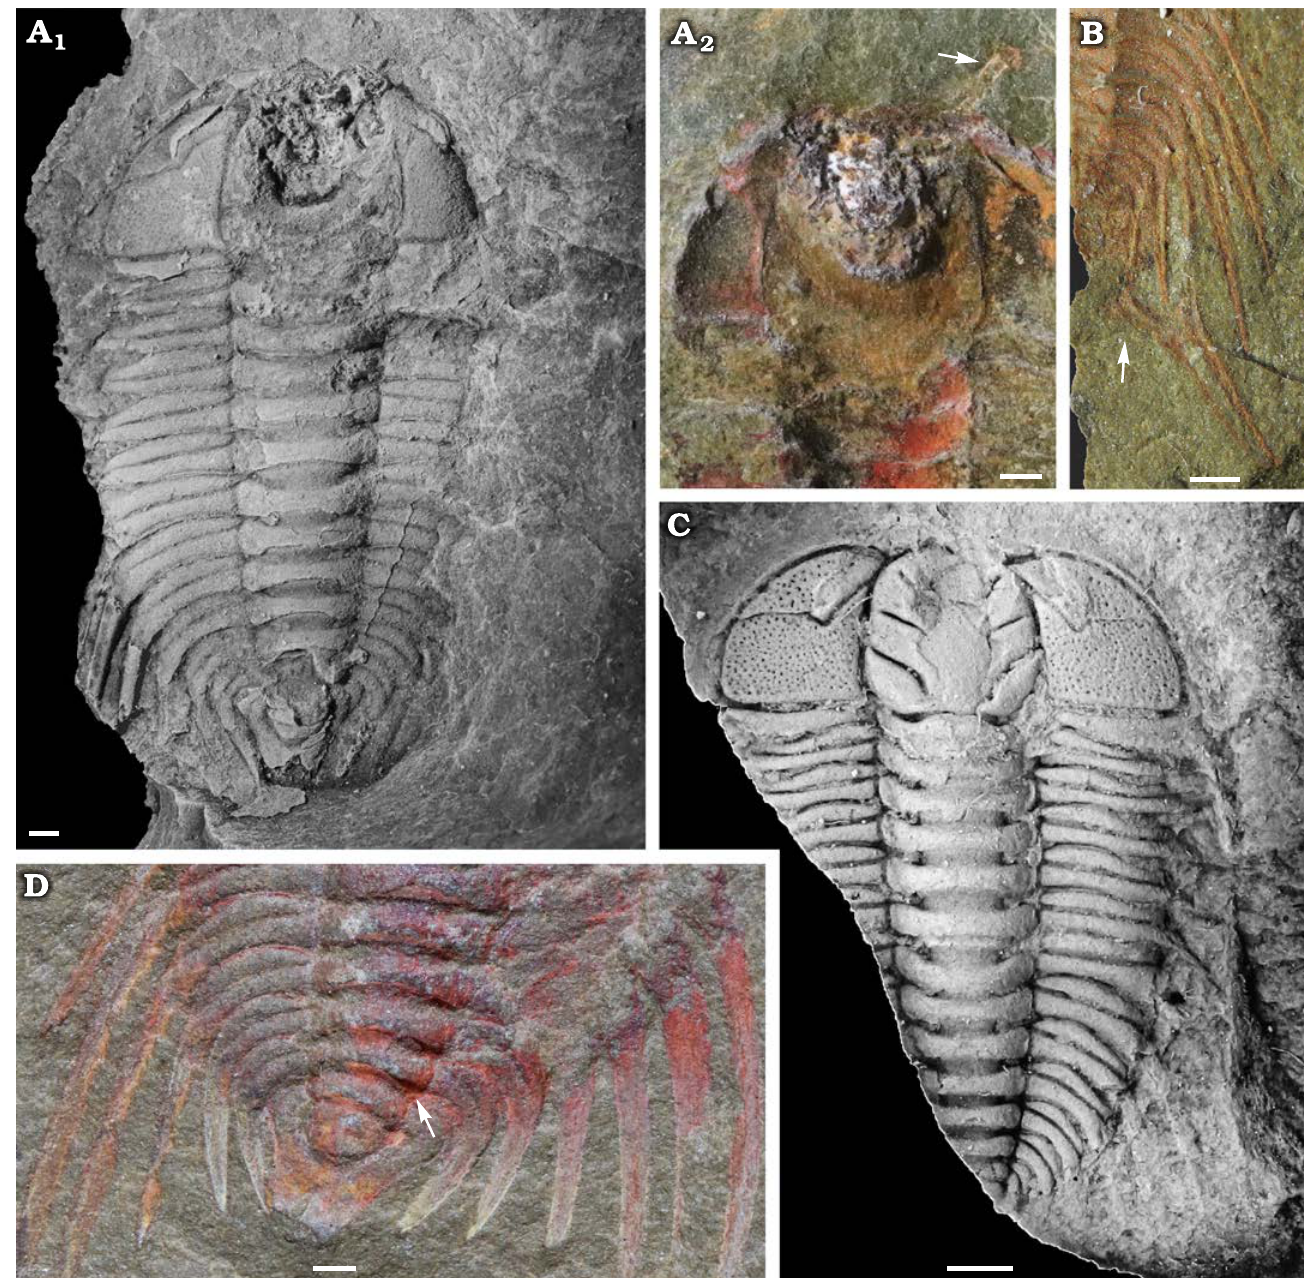
Fig. 1. Cheirurid trilobite Anacheirurus adserai (Vela and Corbacho, 2007) from the Fezouata Shale, Araneograptus murrayi Zone, Tremadocian, Lower Ordovician, near Beni Zouli, Zagora Province, Morocco. A . MGL 102179, complete specimen (A 1 ) and anterior region of the counterpart (A 2 ); arrow pointing the antennae. B . MGL 102170, close-up of the posterior region of the trunk; arrow pointing the disarticulated pygidium. C . ML20-269198, latex cast of the counterpart. D . YPM 525125, close up of the posterior region of the trunk; arrow pointing the articulation between the thorax and the pygidium. Specimens in A 1 and C coated with ammonium chloride. Scale bars 1 (YPM 522182). Cephalon semi-elliptical in outline, rela- tively short (sag.), length/width ratio ranges from 1.04 to material come from the Fezouata Shale, Upper Tremadocian 0.88. Glabella sub-quadratic in shape, parallel-sided, slightly (Tr3), Araneograptus murrayi Zone, Lower Ordovician. tapering anteriorly. Anterior glabellar margin bowed anteri- Description .— Exoskeleton : Exoskeleton micropygous (Fig. orly. Posterior glabellar margin slightly bowed anteriorly me- 1A B, C), ovoid to sub-ovoid in outline (excluding spines) dially. Three pairs of well-defined lateral glabellar furrows , (Fig. 1A , C). The sagittal length of the observed holaspid (Fig. 1C). S1 deeper, longer (tr.), and wider (sag.) than S2 1 individuals ranges from 5.6 mm (MGL 101262) to 35 mm and S3, directed inwards and slightly backwards, adaxially